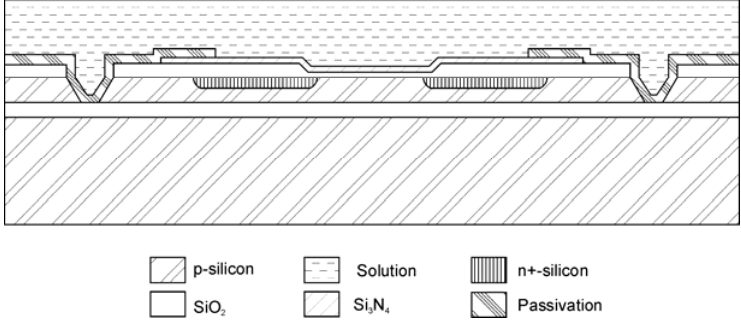
Figure 3. Cross-sectional schematic representation of a trench-isolated NMOS